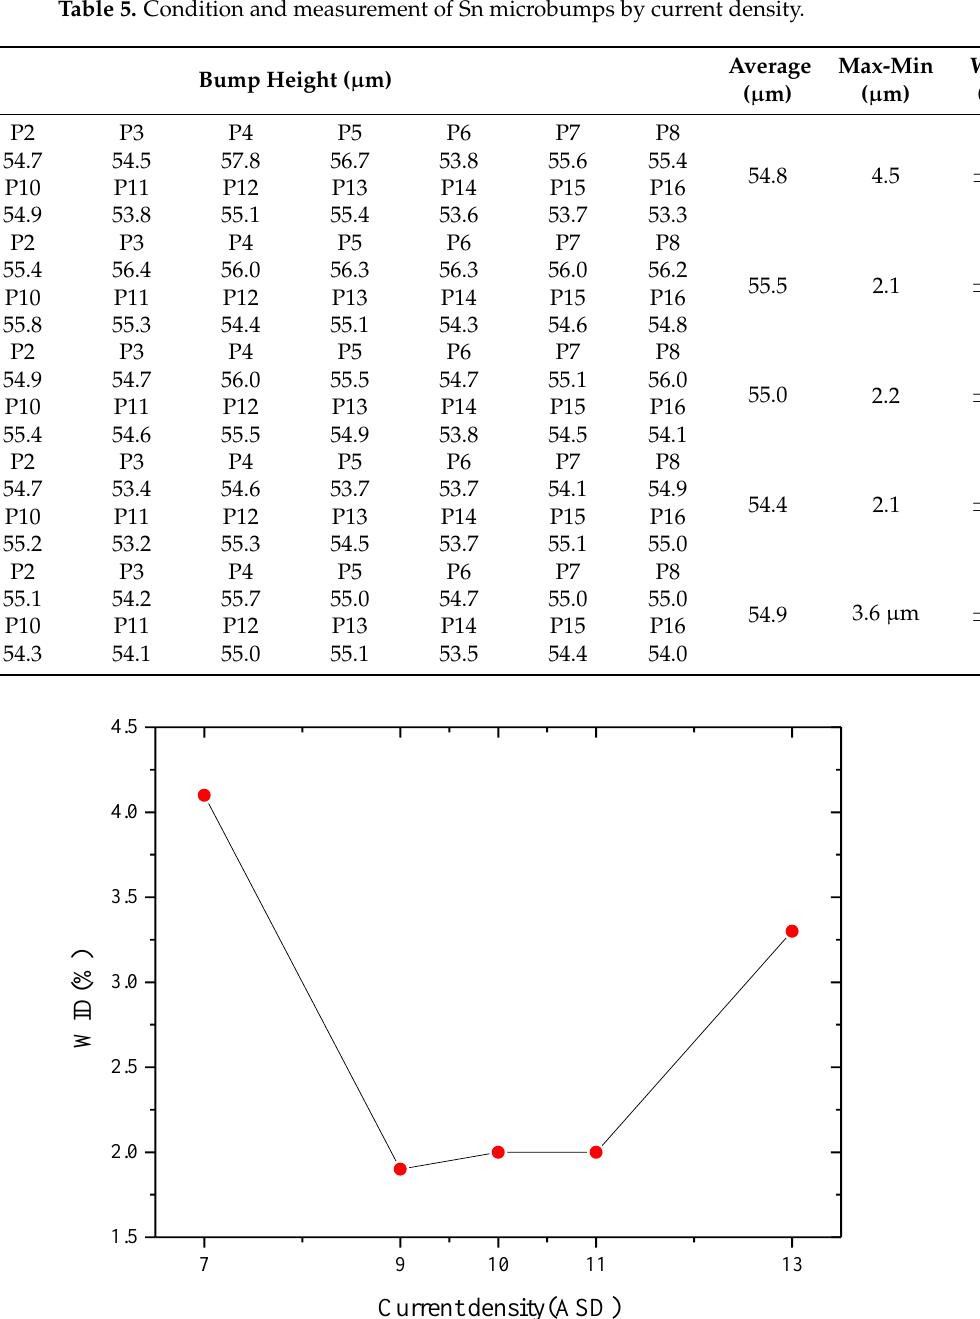
Table 5. Condition and measurement of Sn microbumps by current density.